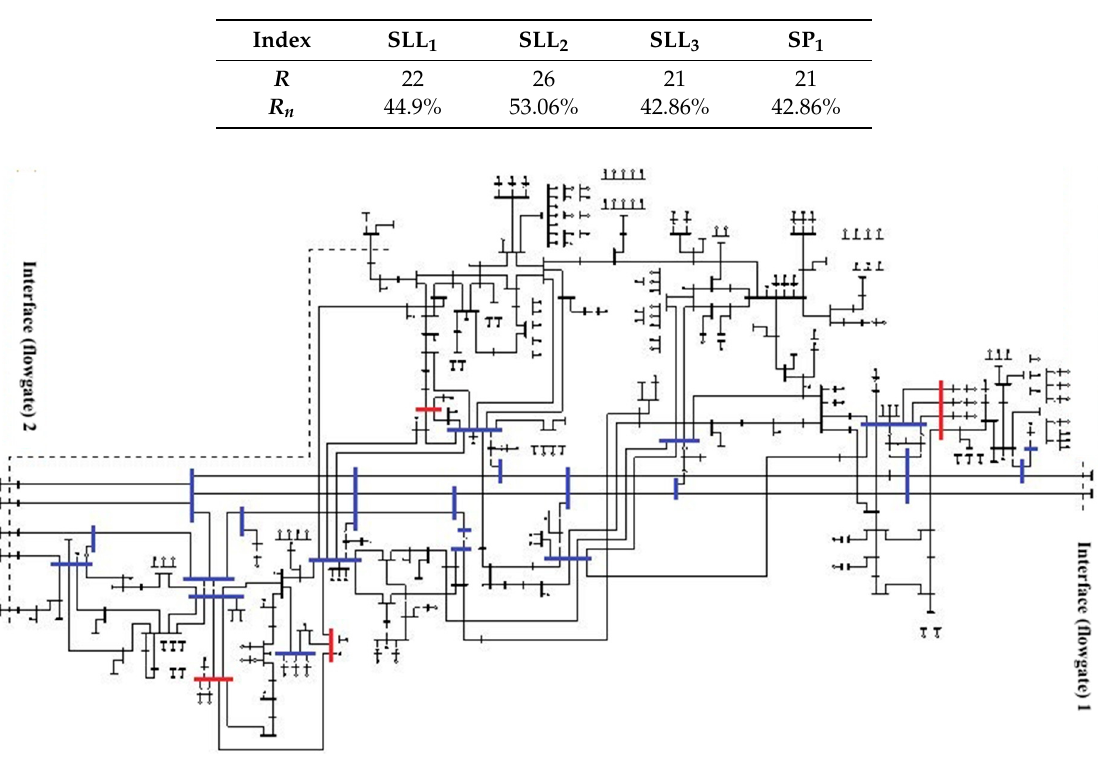
Figure 11. One-line diagram comparison for dispatches SLL 1 and SLL 2 .